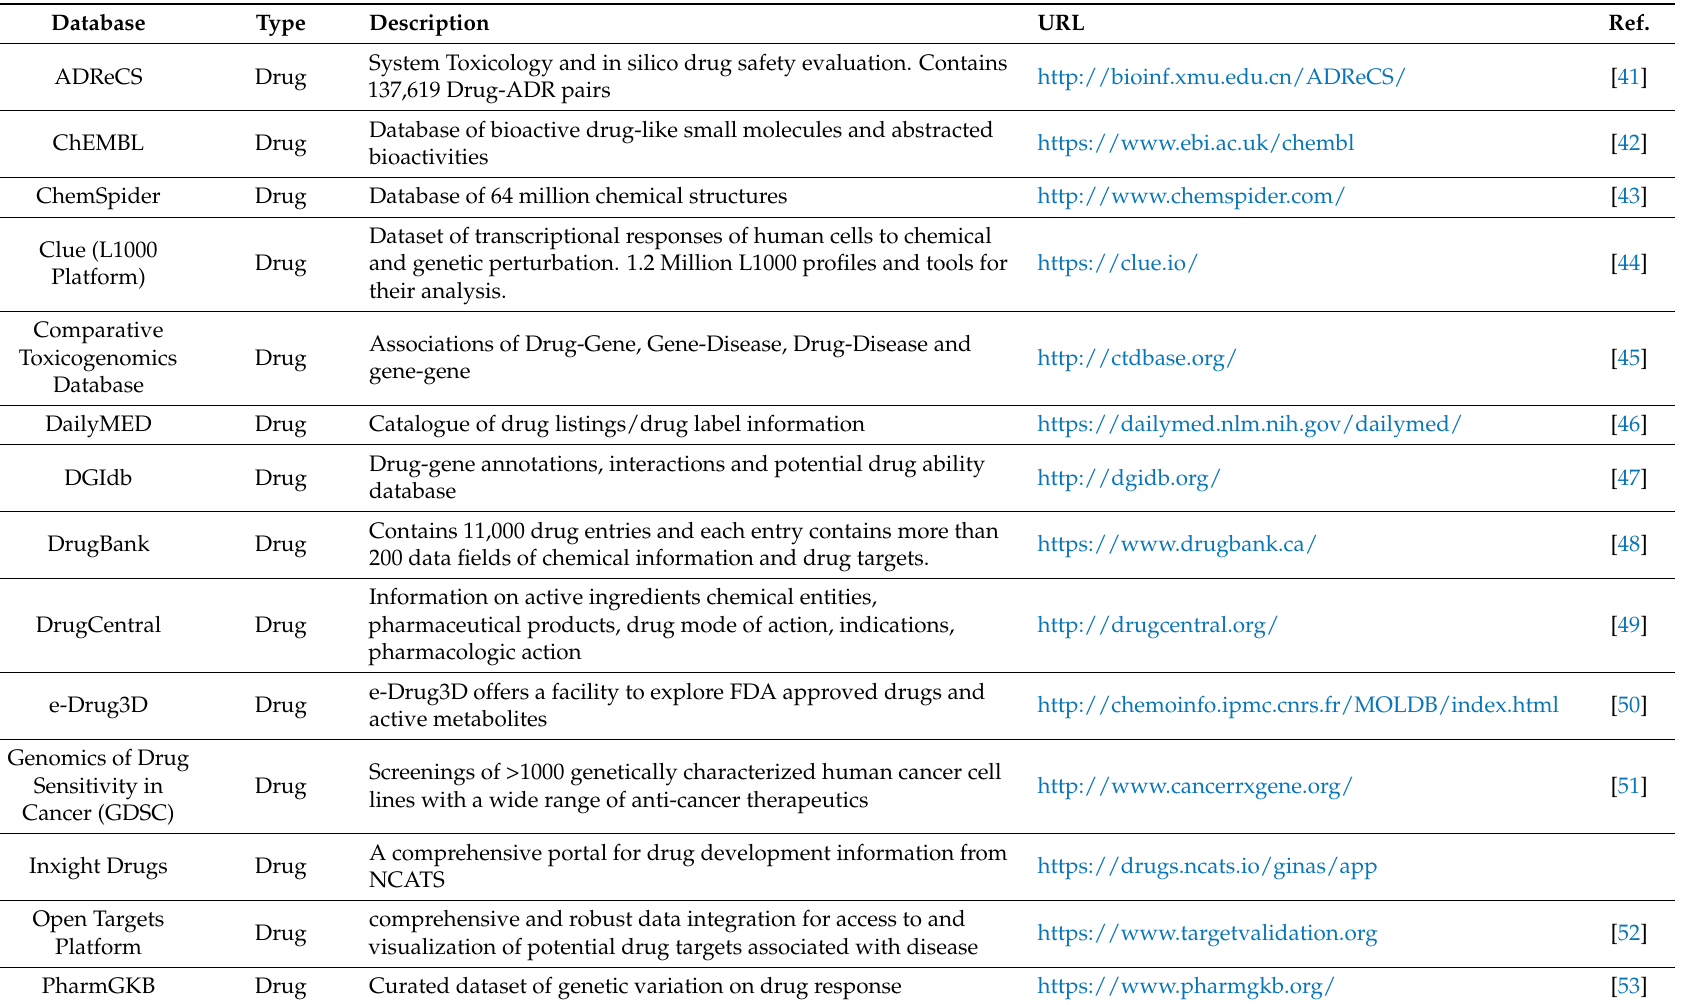
Table 2. Drug and Disease Centric Database